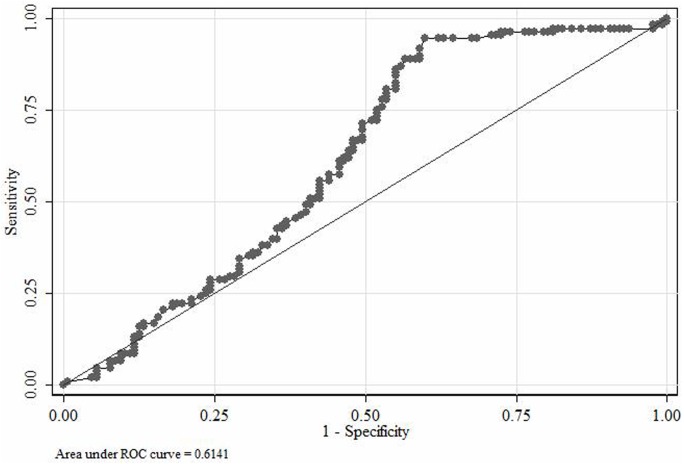
Significant GM cut-off according to IA cases defined on the basis of EORTC/MSG criteria (for calculation proven and probable IA cases are taken as one group whilst combining others together).